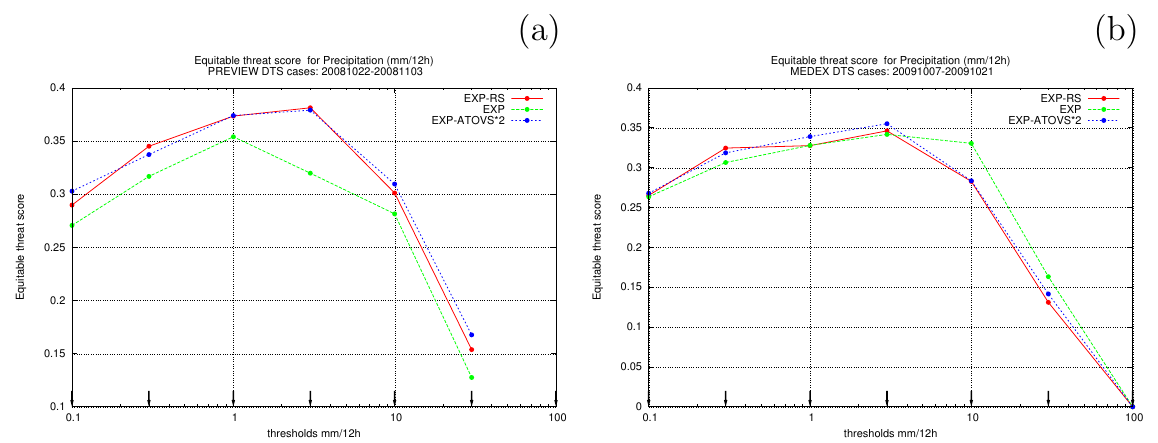
Fig. 8. Equitable threat score (ETS) for precipitation (in mm12h − 1 ) for EXP, EXP-RS and EXP-ATOVS for (a) PREVIEW-DTS cases and (b) and MEDEX-DTS